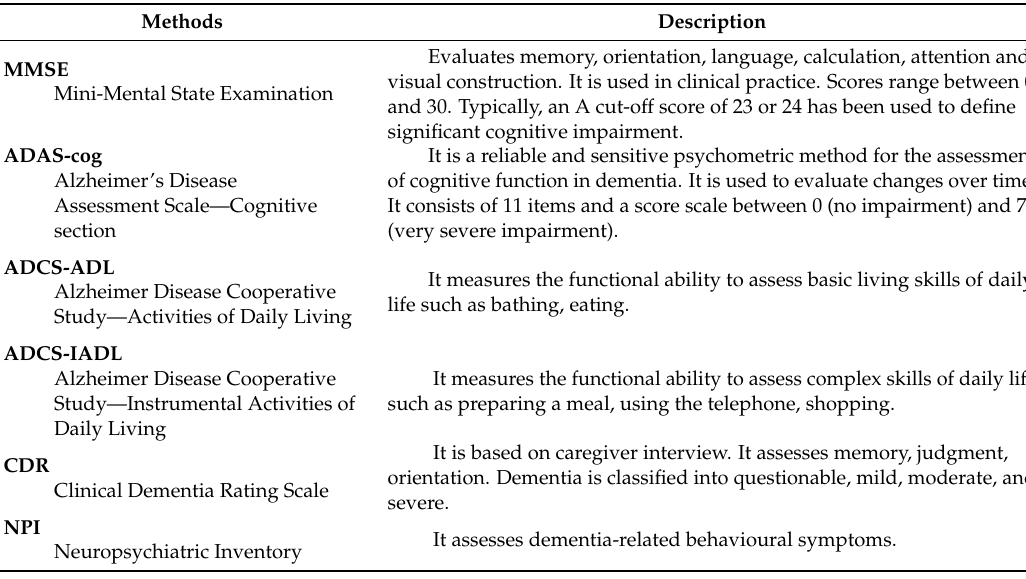
Table 3. Methods used for cognitive assessment in AD